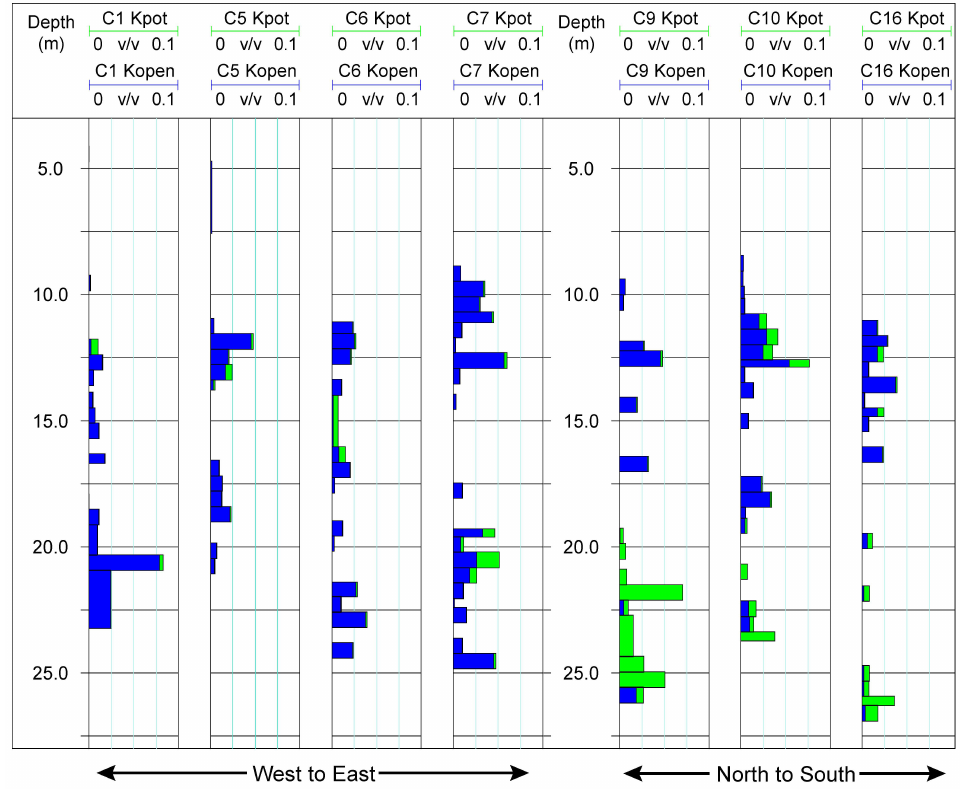
Figure 5. Cross section of multiple wells showing the lateral and vertical distribution of dissolution- enhanced vugs (karst) observed using the NMQP methodology. Attributes displayed correspond to ϕ 22pot and ϕ 22 (Kpot and Kopen, respectively, in log headers), with the well name preceding each of them (e.g., C1 Kpot). The blue fill represents the proportion of vug porosity that is open, and the green fill corresponds to the proportion of vug porosity filled with cements.